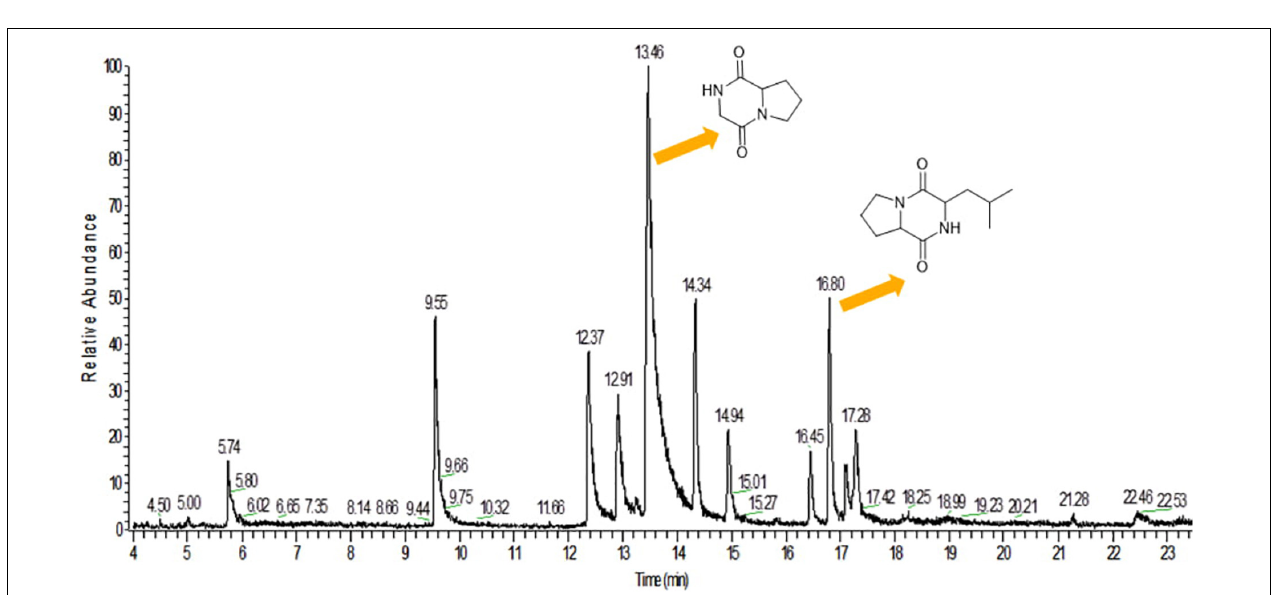
FIGURE 3 | HPLC chromatogram of methanolic crude extract of B. seminalis JRBHU6 obtained at PDA 210 nm showing characteristic peaks with retention time 1.961 min., 2.245 min., 5.103 min. and 6.121 min. The eluted active compounds at retention time 2.245 min. having the highest peak area was subjected to further characterization